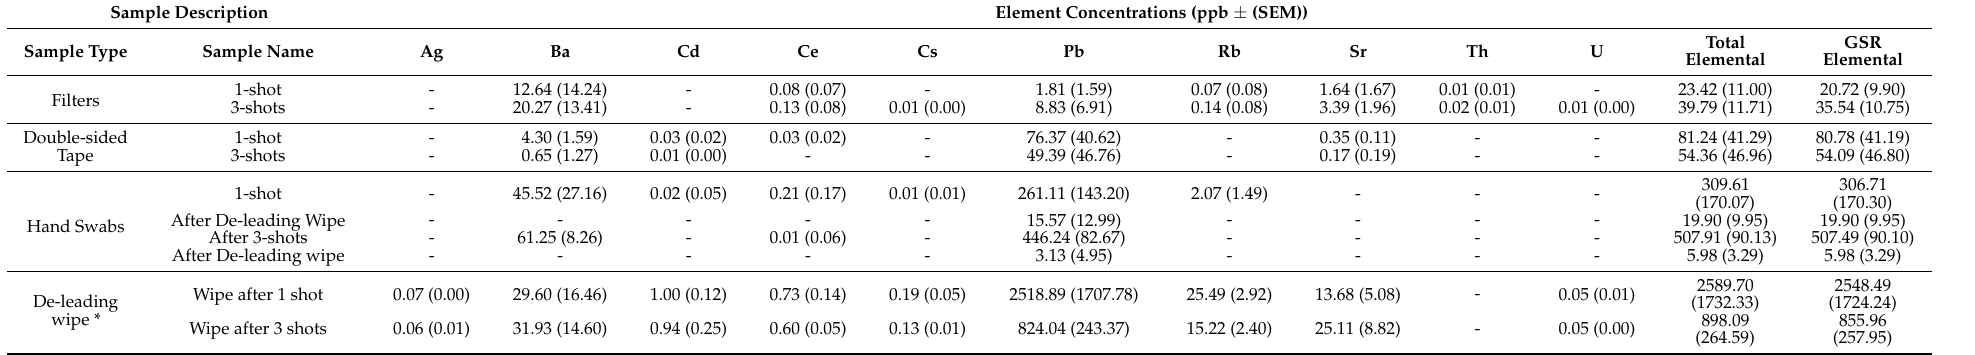
Table 1. Elemental Concentrations for All Sample